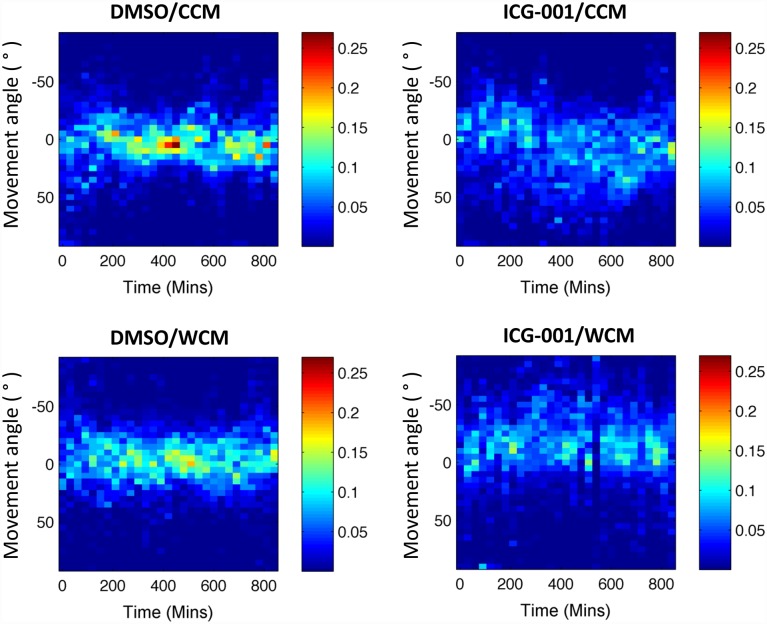
Movement angle is the angle between expected sheet direction (i.e. wound closing or 0°) and PIV determined velocity vectors.Color bar indicates fraction of all PIV vectors with a particular orientation. Reference condition is DMSO treated and dysregulated condition is ICG-001 treated. CCM stands for control conditioned media; WCM stands for Wnt3a conditioned media.